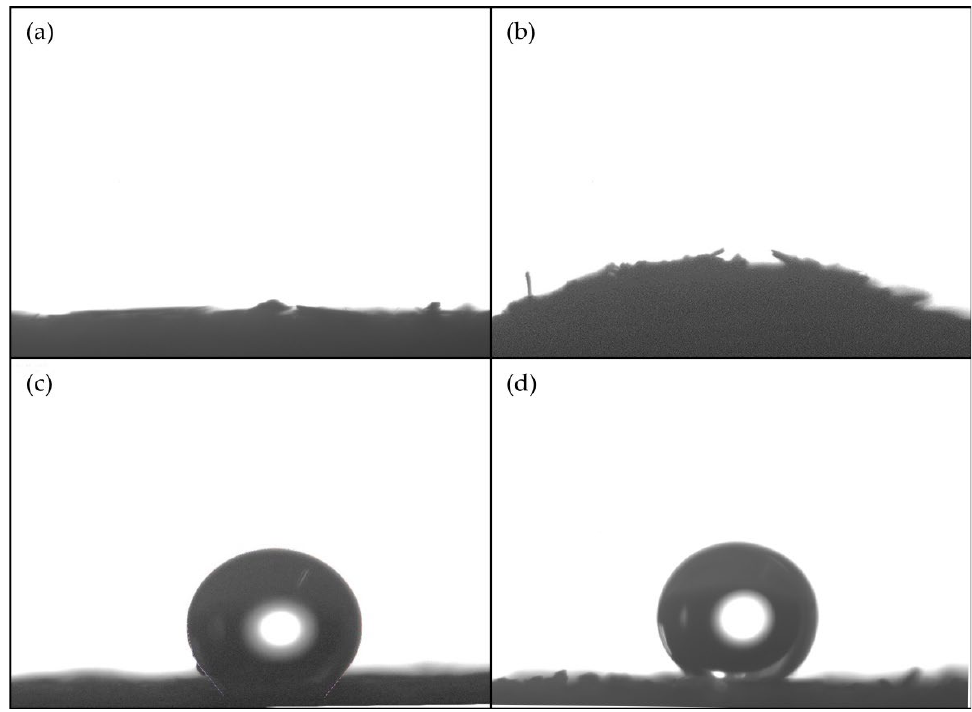
Figure 8. Images of water droplets on different surfaces: ( a ) untreated STF ( b ) SiO 2 treated STF ( c ) PFOTS treated STF ( d ) SiO 2 -PFOTS treated STF.